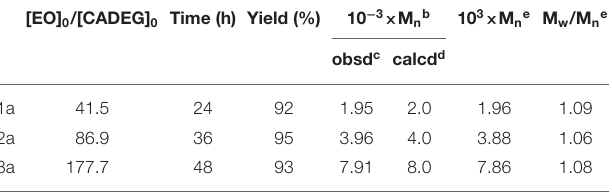
TABLE 1 | Results of anionic polymerization of ethylene oxide (EO) using CADEG as the initiator. [EO] 0 /[CADEG] 0 Time (h) Yield (%) 10 − 3 × M nb